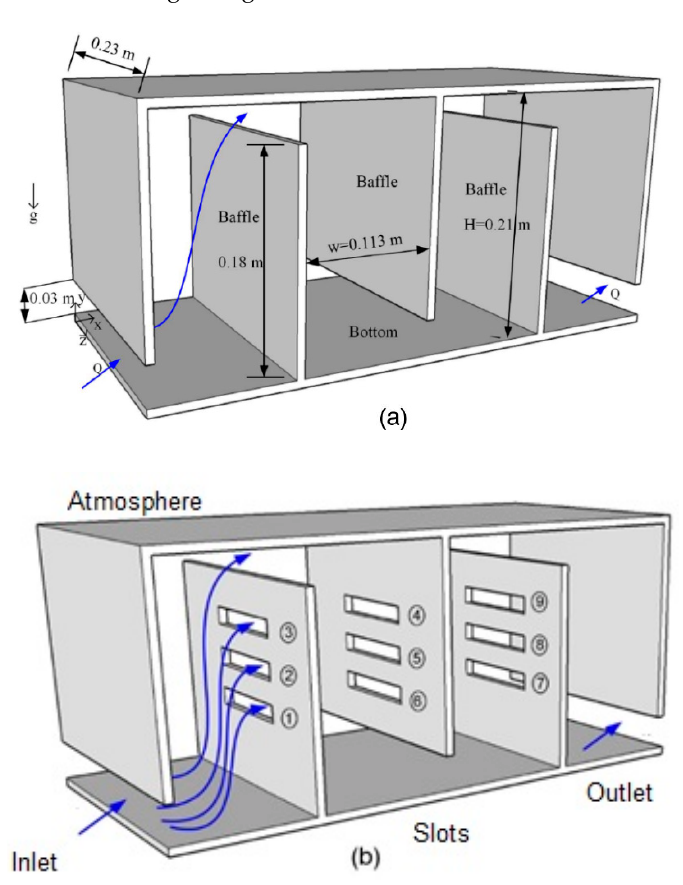
Figure 1. Schematic view of the contact tank: ( a ) baffle without slots case; ( b ) slot-baffle case